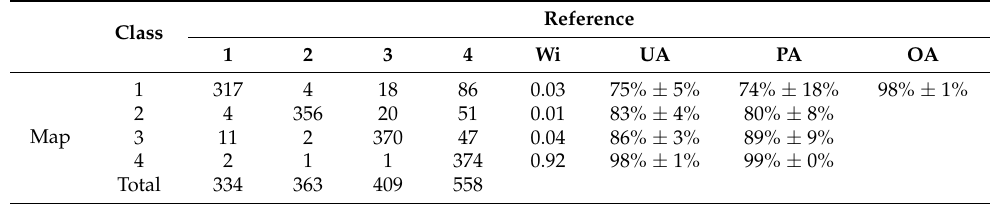
Table 3. Confusion matrix for the forest change map from 2007 to 2017.Class 1 is Non-Forest to Forest, class 2 is Forest to Non-Forest, class 3 is stable forest, and class 4 is stable non-forest. Accuracy measures are presented with a 95% confidence interval.